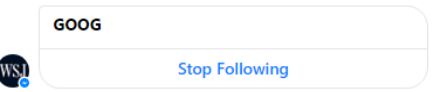
Fig. 8. WSJ’s card with topic (GOOG) and no image.